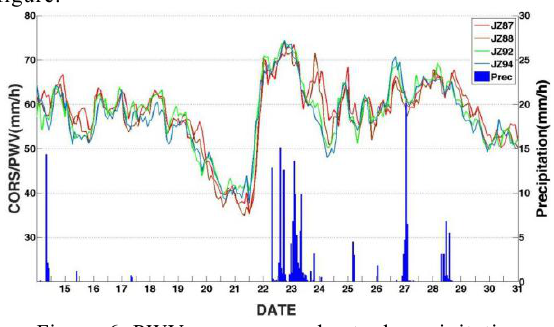
Figure 6. PWV sequence and actual